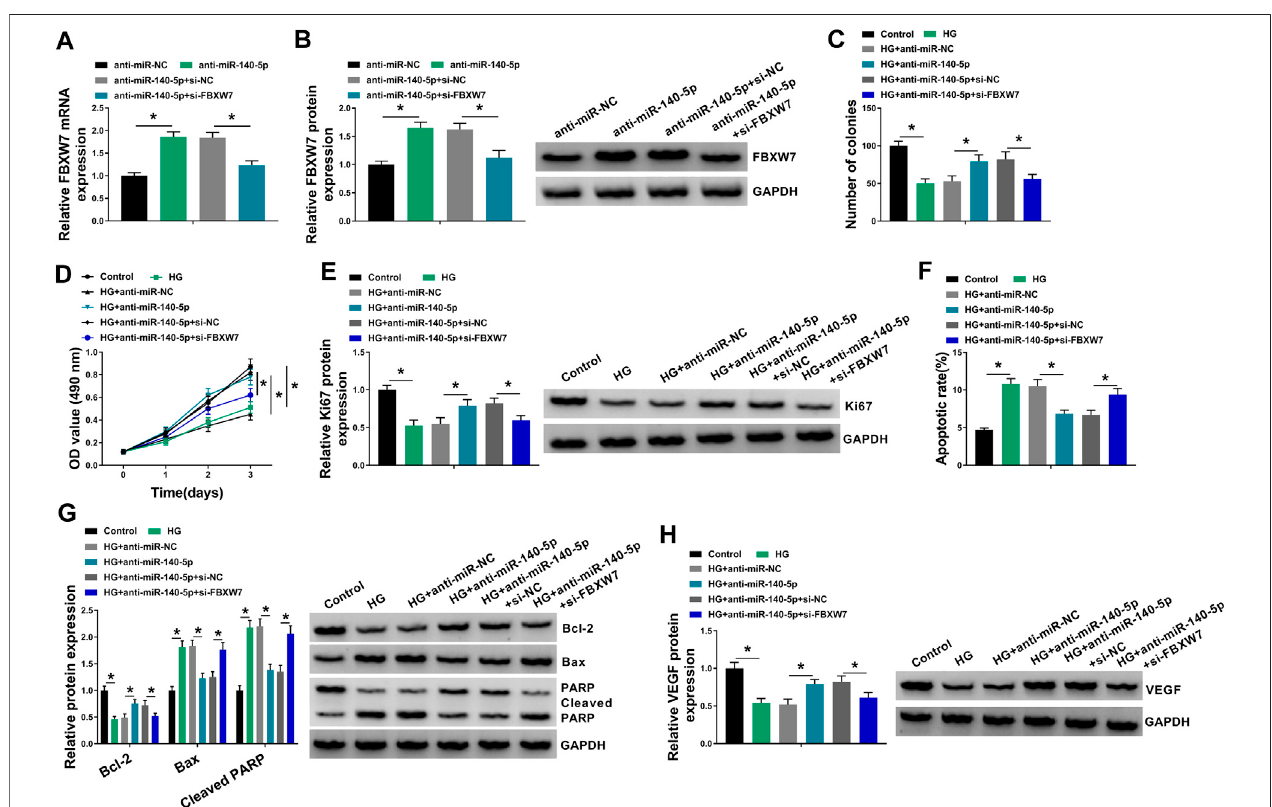
FIGURE6| MiR-140-5p regulatedHUVECproliferationandapoptosisunderHGconditionsbyFBXW7. (A,B) FBXW7mRNAandproteinlevelsweremeasured by qRT-PCR or Western blot assay inHUVECs transfected withanti-miR-NC, anti-miR-140-5p, anti-miR-140-5p + si-NC, or anti-miR-140-5p +si-FBXW7. HUVECs were transfected with anti-miR-NC, anti-miR-140-5p, anti-miR-140-5p + si-NC, or anti-miR-140-5p + si-FBXW7 before HG treatment, followed by the determination of cell colony formation using a colony formation assay (C) , cell proliferation by MTT assay (D) , Ki67 level by Western blot (E) , cell apoptosis by fl ow cytometry (F) , Bcl-2, Bax and Cleaved PARP levels (G) , and VEGF expression (H) by Western blot. * p < 0.05. n (cid:2) 3 independent biological replicates; data were presented as mean ± SD; * p < 0.05 by ANOVA followed by Tukey – Kramer post hoc test.